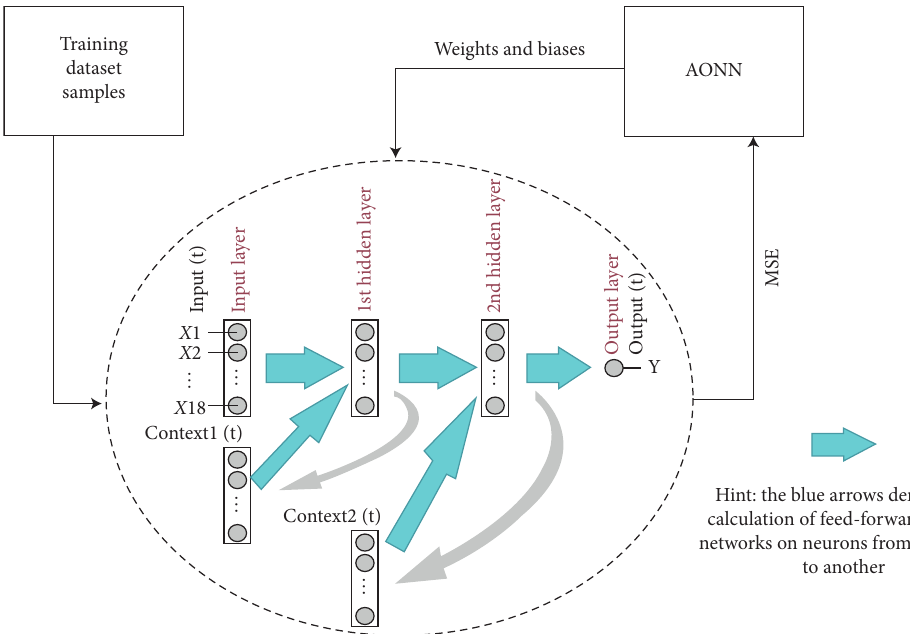
Figure 3: GWO algorithm